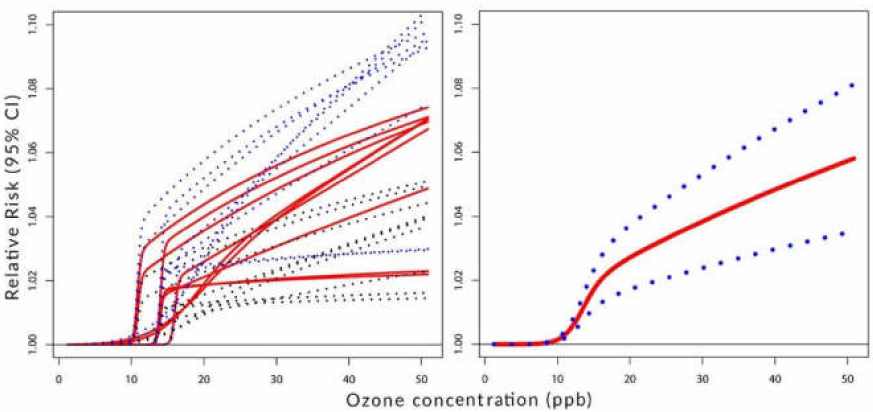
Figure 4. Left panel : C-RF shapes by lags. Right panel : a pooled C-RF shape. Transformation with f ( Z ) = log ( 1 + Z / A )